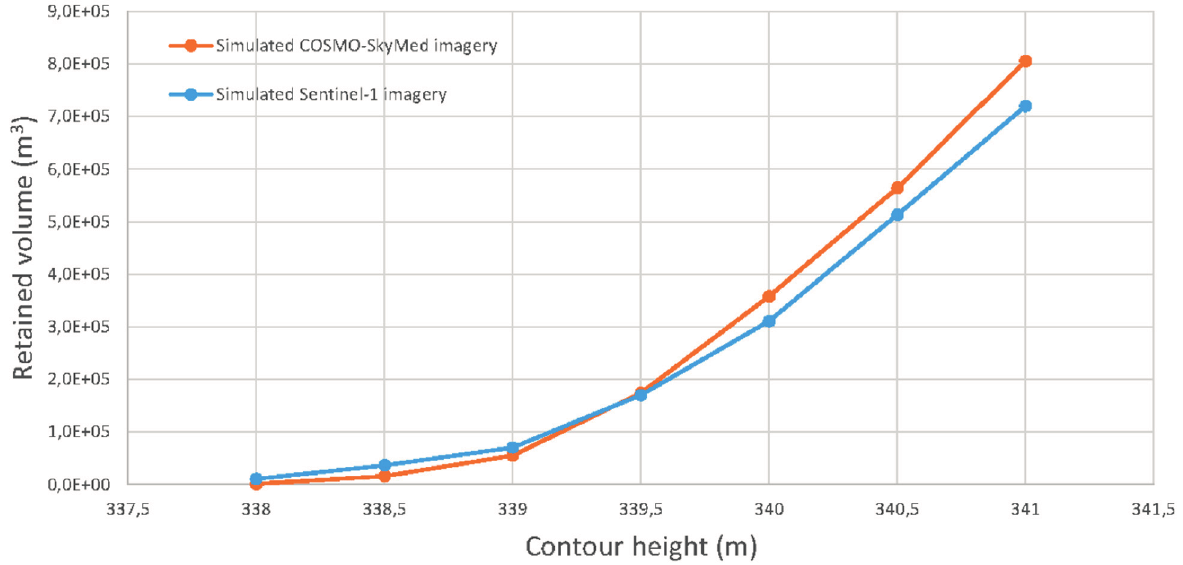
Figure 9. Laaba basin: retained water volume as function of the contour